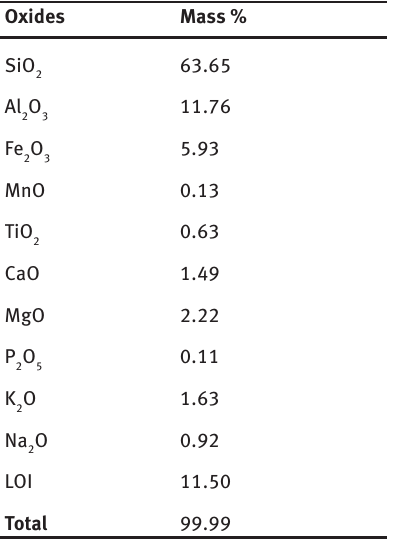
Table 2: Chemical composition of trepel.